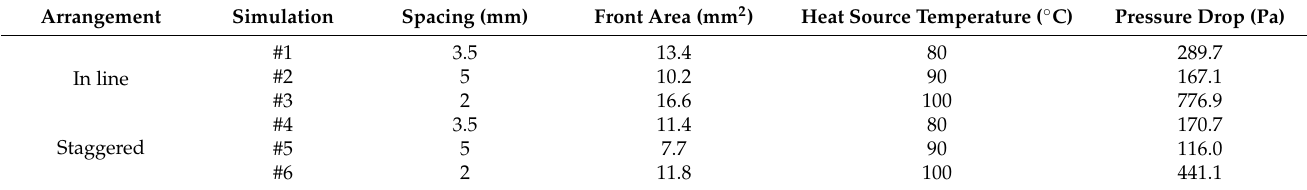
Table 7. Correlation between pressure drop and geometrical parameters for an inlet air velocity of 3.51 m/s.